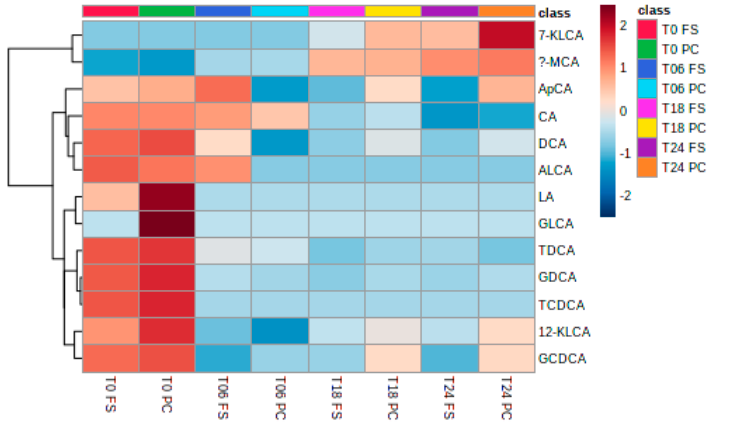
Figure 7. Heatmap of the bile acid production during fermentation. T0, T6, T18, T24 = observed timepoints 0 h, 6 h, 18 h, and 24 h; PC = digested flaxseed press cake, FS = digested milled whole flaxseed.